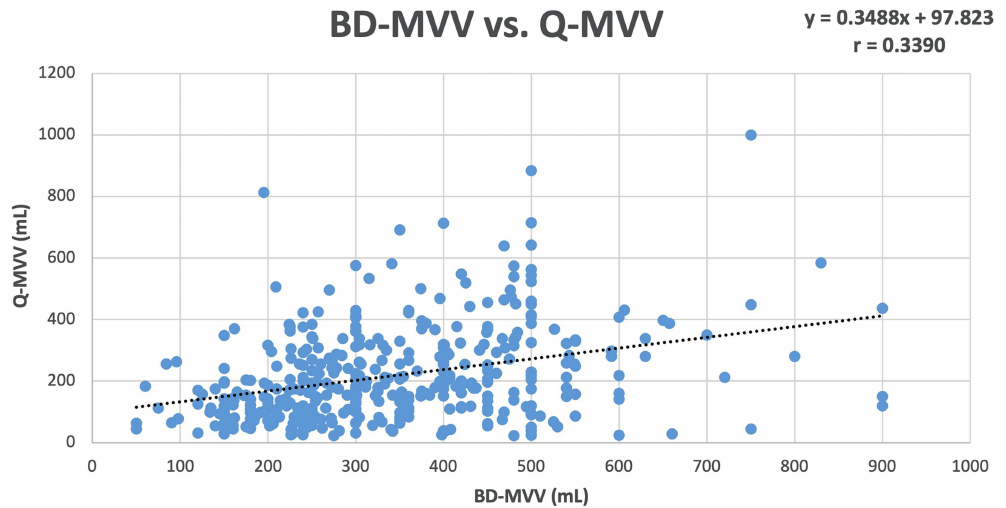
Figure 1 - Scatterplot of BD-MVV vs. Q-MVV